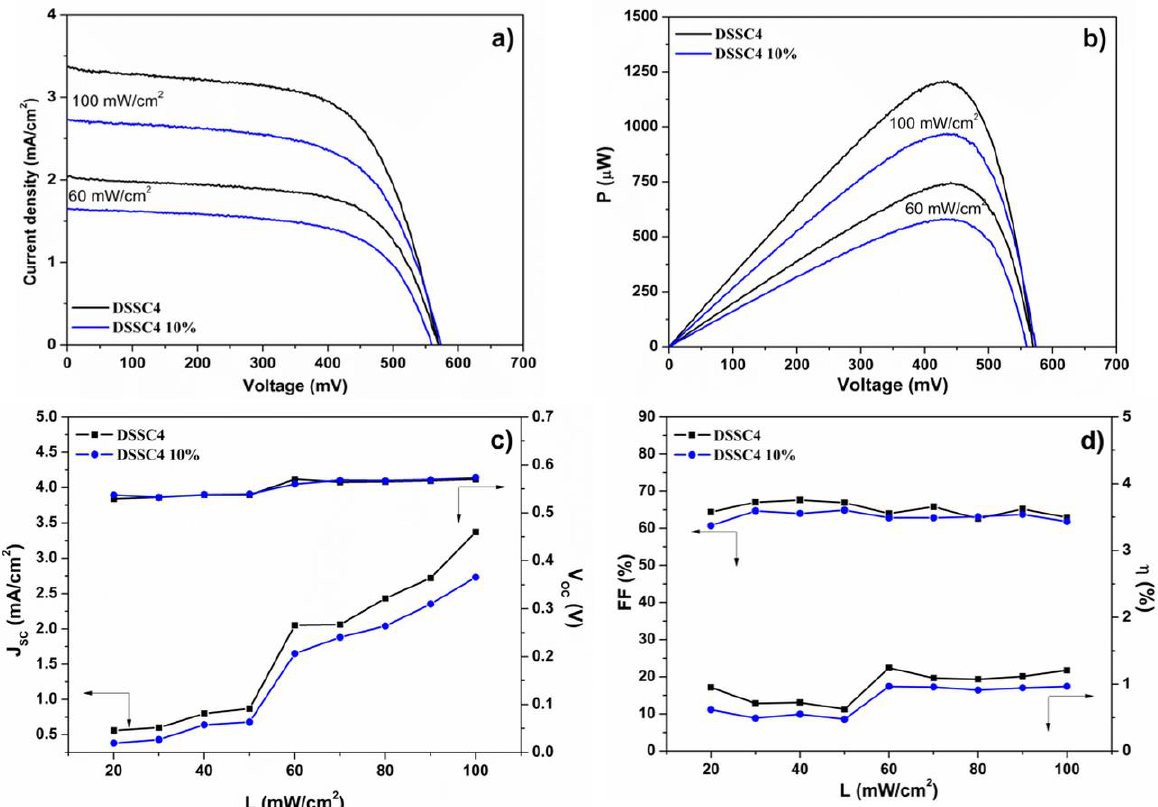
Figure 13. The photovoltaic performance of curcumin sensitized DSSC4 under different illumination intensities tested using E and E10% electrolytes: ( a ) J – V characteristics; ( b ) voltage dependence of the calculated power P; ( c ) dependence of V OC and J SC on the illumination intensity; ( d ) dependence of efficiency and fill factor on the illumination intensity.